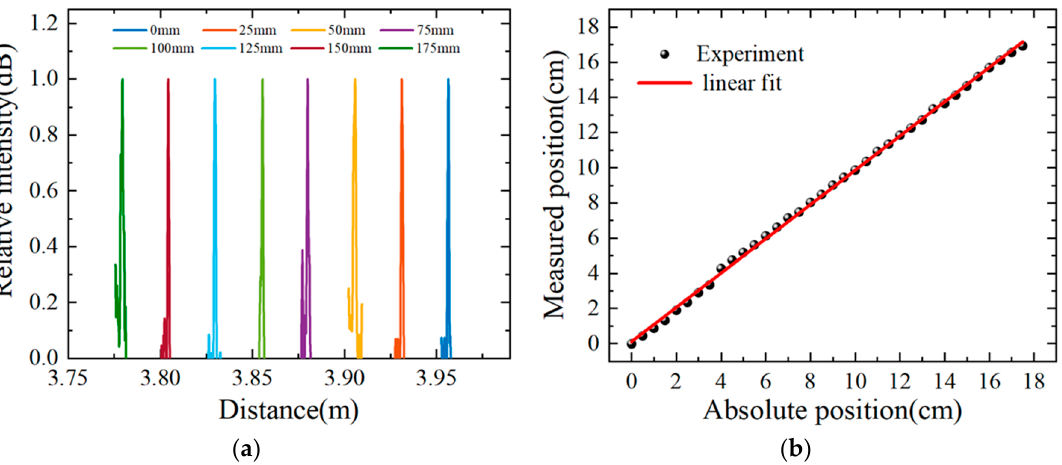
Figure 8. Liquid-level sensor in a range of 175 mm with an interval of 5 mm. ( a ) Normalized reflection peak drift with liquid level; ( b ) linear fit of measured position and absolute position of liquid level.